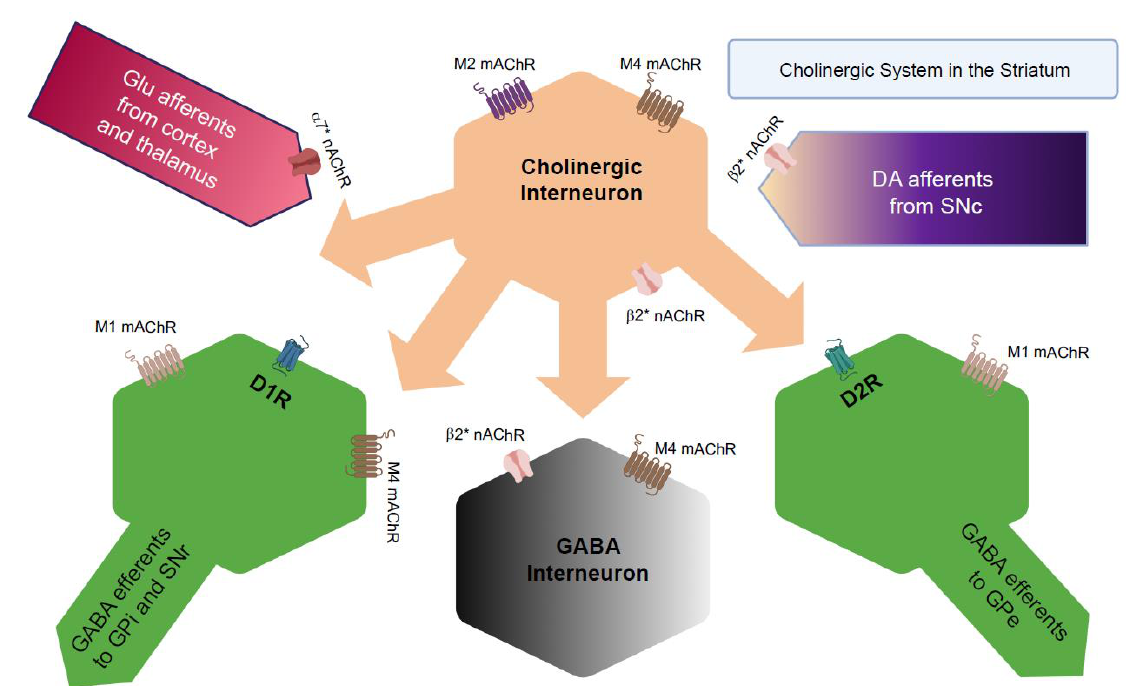
Figure 6. Characterization of cholinergic interneurons in the striatum. Schematic representation of interconnections between CINs and other neurons in the striatum. The direct MSNs that project preferentially to the GPi/SNpr express D 1 Rs along with M1 (M1R) and M4 receptors (M4R). The indirect MSNs that project to the GPe express D 2 R along with M1Rs. β 2* nAChs and α 7 nAChRs are expressed on the axonal terminals of the nigrostriatal DAergic neurons and corticostriatal glutamatergic neurons. CINs also express multiple cholinergic receptors that include β 2* nAChRs, M2Rs, and M4Rs. Figures created with https://biorender.com/ (accessed on 12 April 2021).